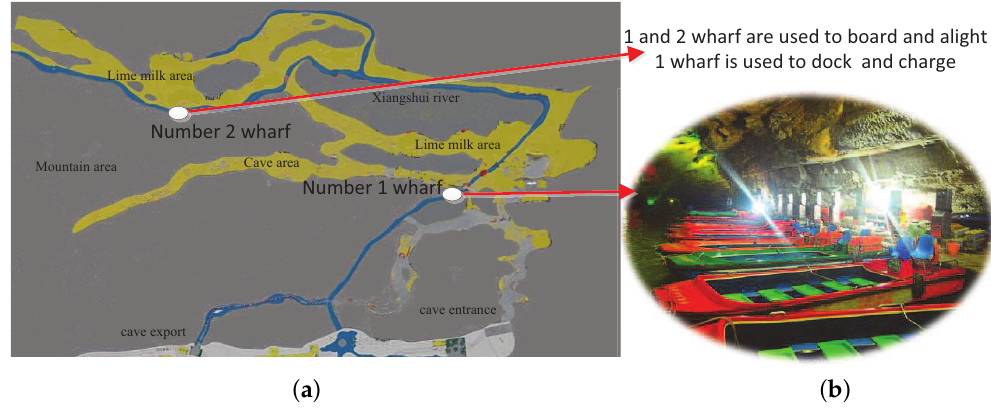
Figure 1. This is a figure describing running map and designed boats. Two parts are separately explained as follows: ( a ) Map of the Huanglong Cave. Underground rivers are annotated using blue lines; ( b ) The scene graph of wharf is contained in the right. The actual operation electric boat and charging pile are also shown in the figure.